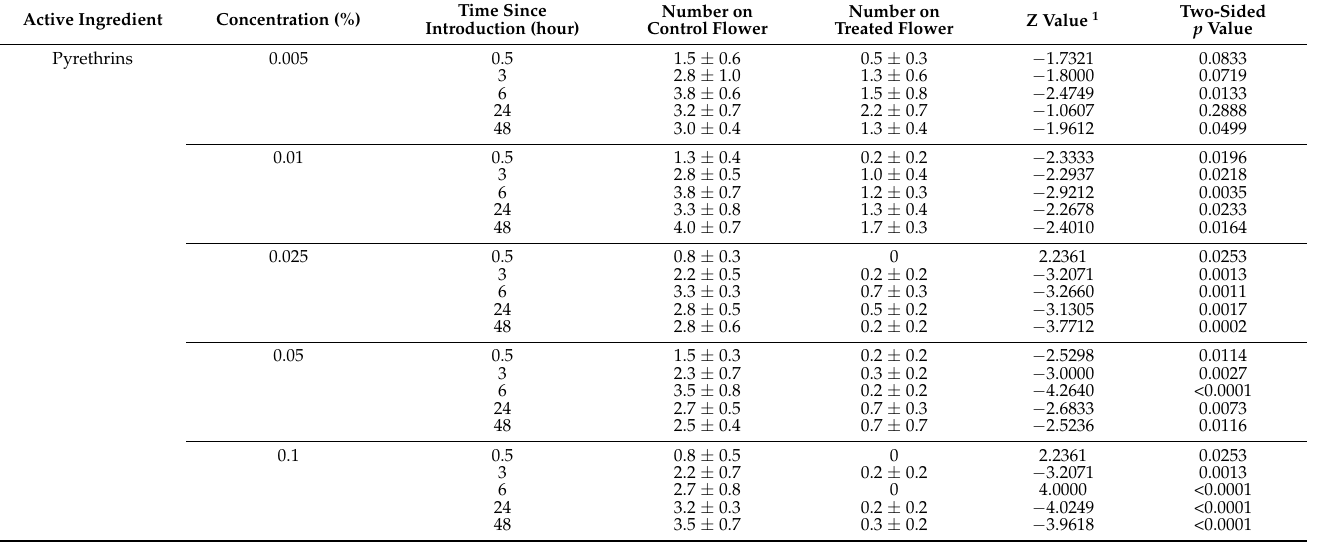
Table 3. Mean numbers ( ± SEM) adult western flower thrips observed on periwinkle flowers treated with Tween 20 (control) and with a plant extract at specific concentration in two-choice repellency (concentrations)